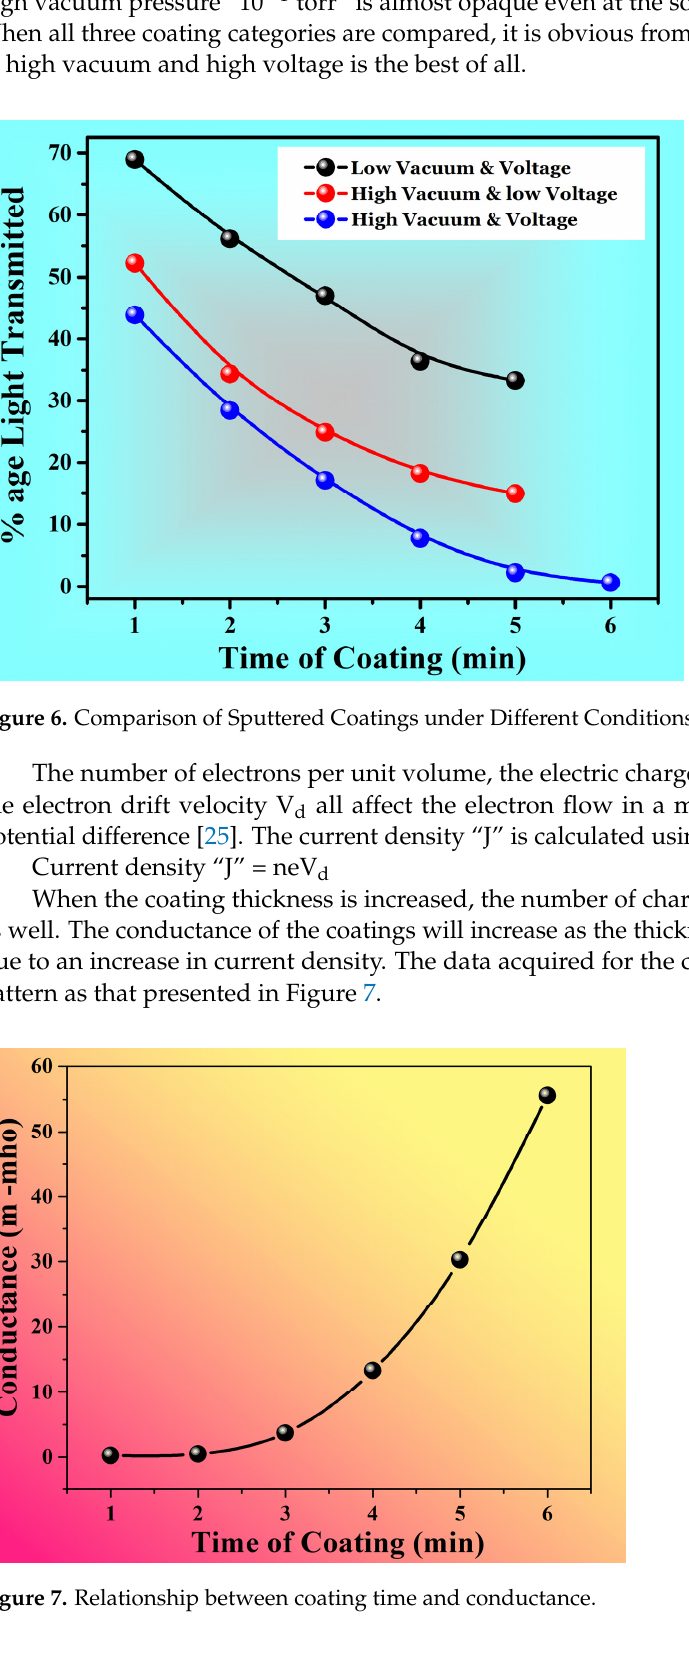
Figure 6 depicted the percentage light transmittance as a function of voltage at various time intervals. It is clear from this graph that the light transmittance of the coating obtained after 6 min is almost zero. The substrate coated for 12 min at high voltage “1.45 KV” and high vacuum pressure “10 − 1 torr” is almost opaque even at the source intensity of 700 Lux. When all three coating categories are compared, it is obvious from Figure 6 that the coating at high vacuum and high voltage is the best of all.